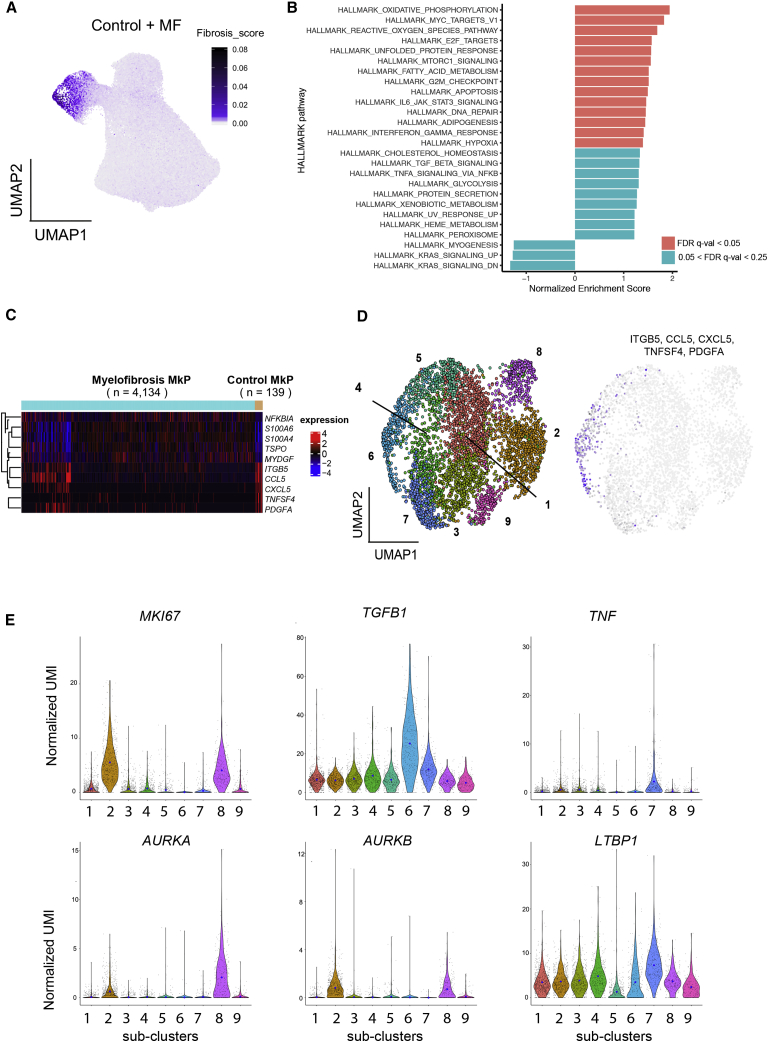
Myelofibrosis MkPs Strongly Express Mediators of Tissue Fibrosis(A) Expression of a 14-gene “fibrosis score” (Table S5) derived from previously published datasets examining bone marrow, liver, and lung fibrosis superimposed on the UMAP of all HSPCs identifies cells in the MkP cluster as the strongest expressers of mediators of tissue fibrosis.(B) HALLMARK pathways from gene set enrichment analysis (GSEA) of all genes pre-ranked according to differential expression in myelofibrosis versus healthy donor MkP. Pathways with a false discovery rate (FDR) q-value of <0.25 are shown.(C) Heatmap showing 10 selected genes differentially expressed between myelofibrosis and control MkP.(D) Left: 9 distinct clusters of myelofibrosis MkP shown on UMAP. Right: expression of signature genes detected in healthy donor MkP and shown in (C) (ITGB5, CCL5, CXCL5, TNFSF4, and PDGFA) shown on UMAP of myelofibrosis MkP indicates that sub-cluster 6 is transcriptionally similar to control MkP.(E) Heterogenous expression of markers of proliferation (MKI67), fibrosis (TGFB1 and LTBP1), inflammation (TNF), and treatment targets (AURKA and AURKB) among myelofibrosis MkP sub-clusters. Blue dots on violin plot indicate mean level of expression. See also Figures S4 and S5.